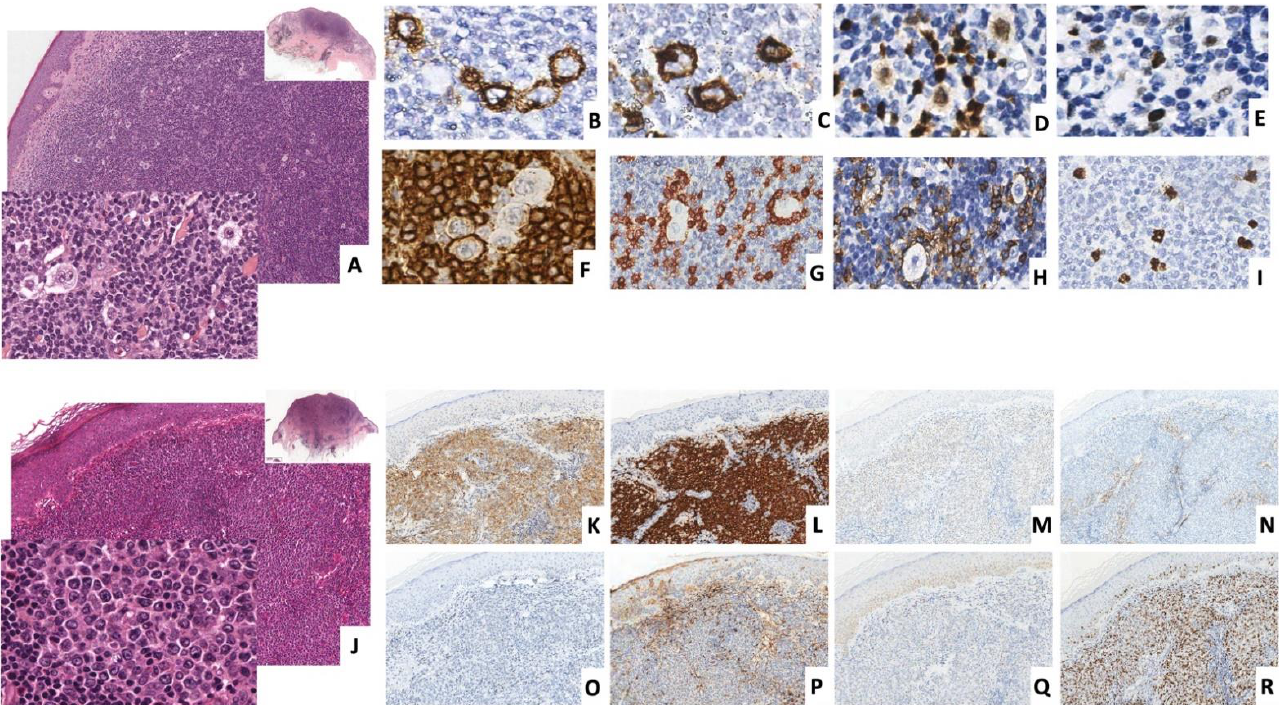
Figure 1. Histology of the skin lesions of patient 1 at diagnosis ( A – I ) and at relapse ( J – R ). At diagnosis the dermis was infiltrated by a small cell lymphocytic infiltrate with several large mono-nucleated or bi-nucleated cells (H/RS-like morphology). (( A ), hematoxylin and eosin, 100×, upper insert 20×, lower insert 400×) expressing CD30 (( B ), 400×), CD15 (( C ), 400×), PAX5 (( D ), 400×), BCL6 (( E ), 400×), and occasionally CD20 (( F ), 400×), and rosetting with small reactive CD3-positive (( G ), 400×) and PD1-positive (( H ), 400×) T lymphocytes. The proliferation index was low and mainly restricted to large cells (( I ), 400×). The cutaneous lesion, relapsed on the scar of the previous nodule, showed a diffuse dermic infiltrate of monomorphic medium-sized to large-sized atypical lymphoid cells (( J ) hematoxylin and eosin, 100× upper insert 20×, lower insert 400×), positive for CD30 (( K ), 100×), CD79a (( L ), 100×), and BCL6 (( M ), 100×) and negative for CD10 (( N ), 100×), BCL2 (( O ), 100×), and IgM (( P ), 100×). MYC was positive in about 30% of the cells (( Q ), 100×). The proliferation index (Ki67) was high (( R ), 100×).